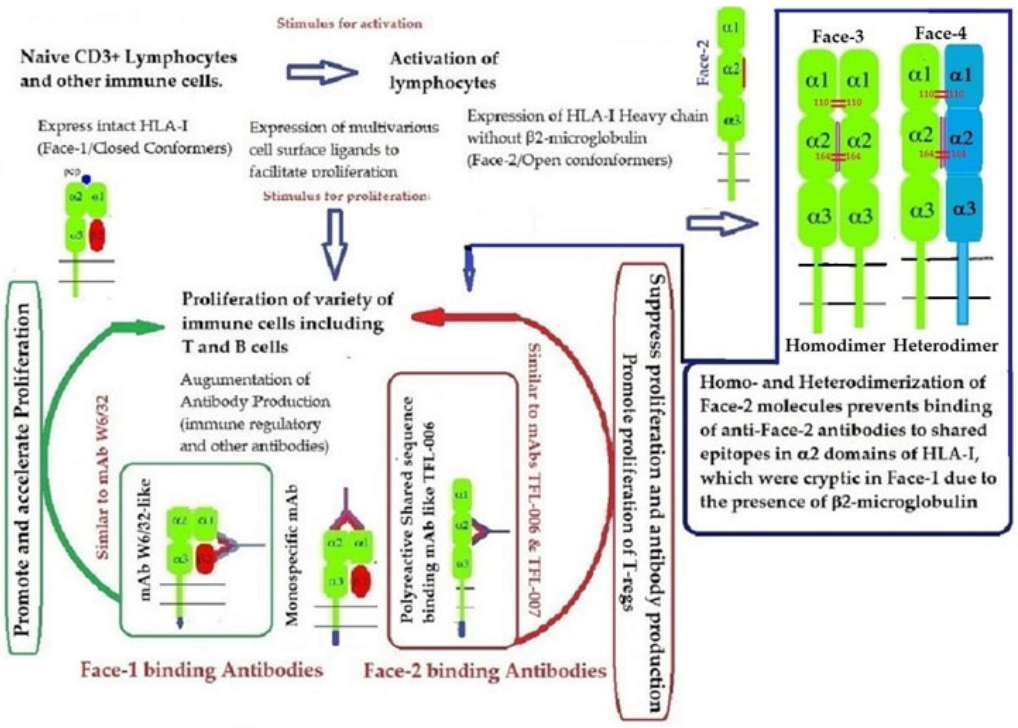
Figure 14. Graphic overview of the roles played by HLA ‐ I structural variants (Face ‐ 1, Face ‐ 2, Face ‐ 3, and Face ‐ 4) together with the Abs directed specifically against Face ‐ 1 (represented by the mAb W6/32) and/or the Abs directed specifically against Face ‐ 2 (exemplified by the mAbs TFL ‐ 006/007) in HLA ‐ I mediated immune homeostasis.